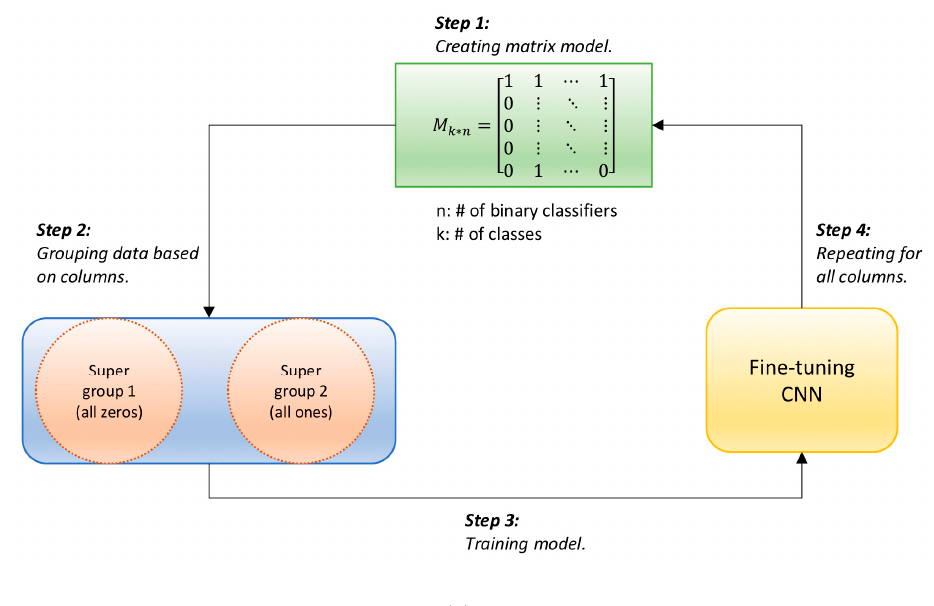
Figure 1. Convolutional neural network (CNN) architectures. ( a ) Fundamental components of CNN and ( b ) Inception